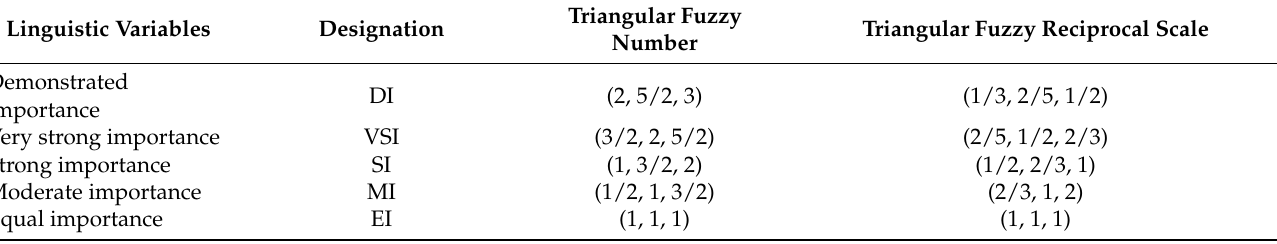
Figure 3. Triangular fuzzy importance scale. Source: Tolga, Demircan [53] (p. 100). Table 8. Fuzzy number